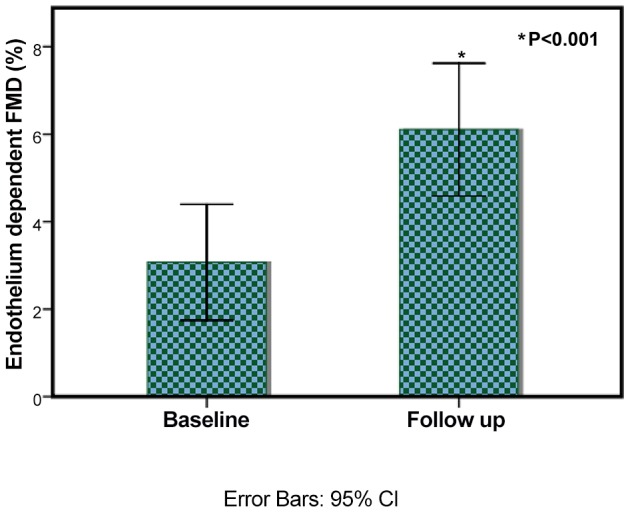
Measure of endothelial function before and after Vitamin D Therapy.Legend: The endothelial function as measured by brachial artery flow mediated dilatation improves from 3.1±3.3% to 6.1±3.7%. Error bars show 95% CI, p<0.001.